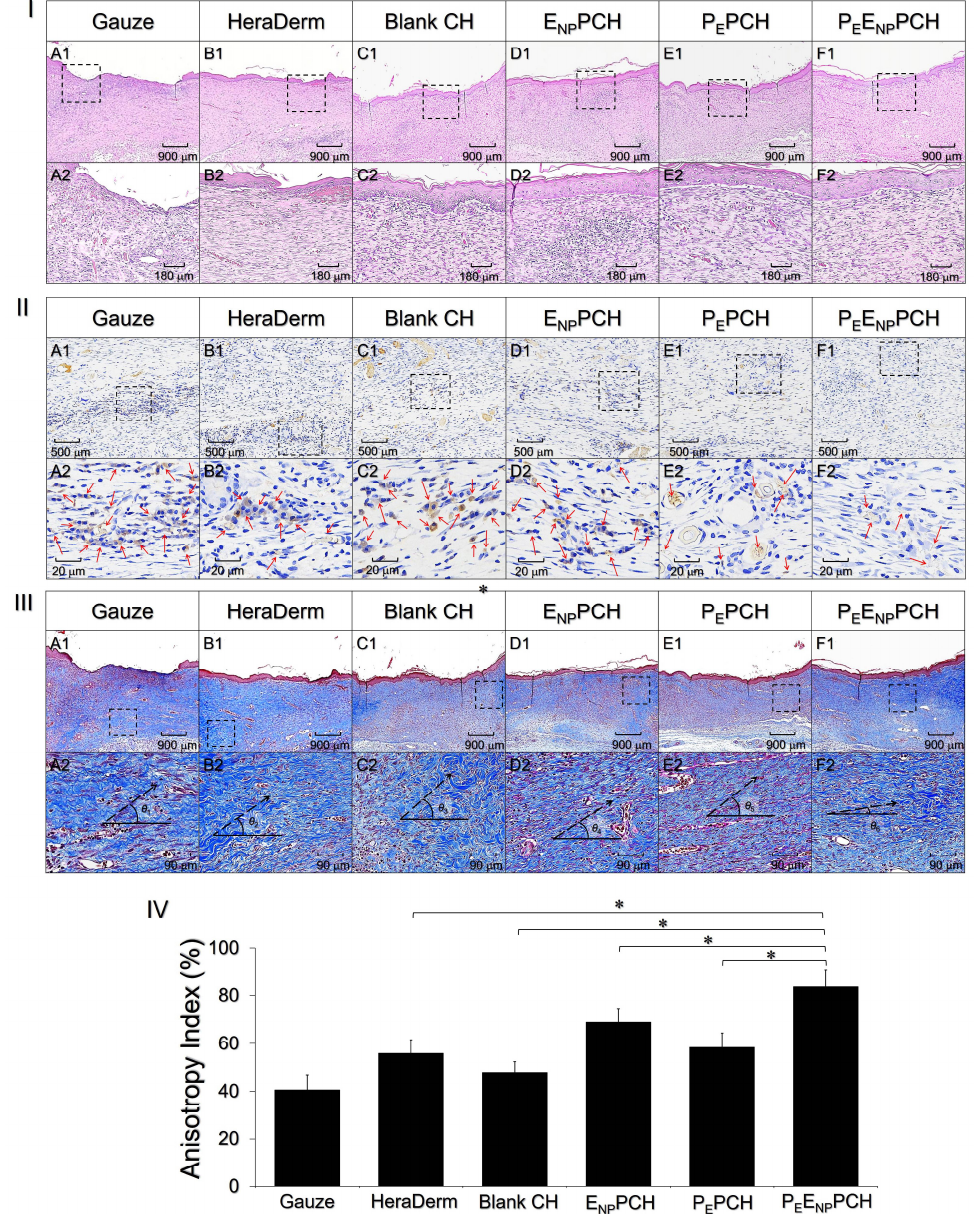
Figure 7. Histological analyses of the skin tissues recovered from the wounds. ( I – III ) Photomicro- graphs of regenerated tissues stained with H&E ( I ), IL-1 β IHC ( II ), and Masson’s trichrome ( III ) after administration of different treatments for 15 days as indicated in the figure. Images ( A1–F1 ) in